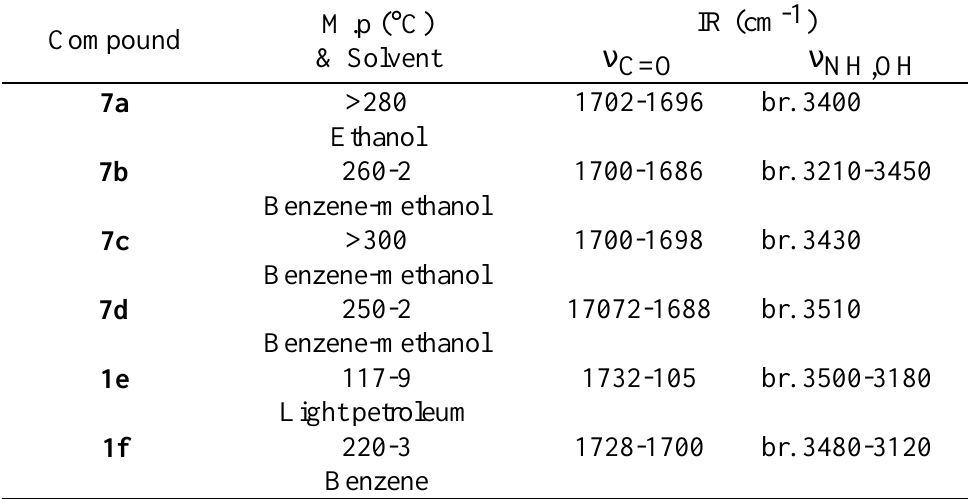
Table 3. Physical data of products of the reaction of 3 with aromatic hydrocarbons and